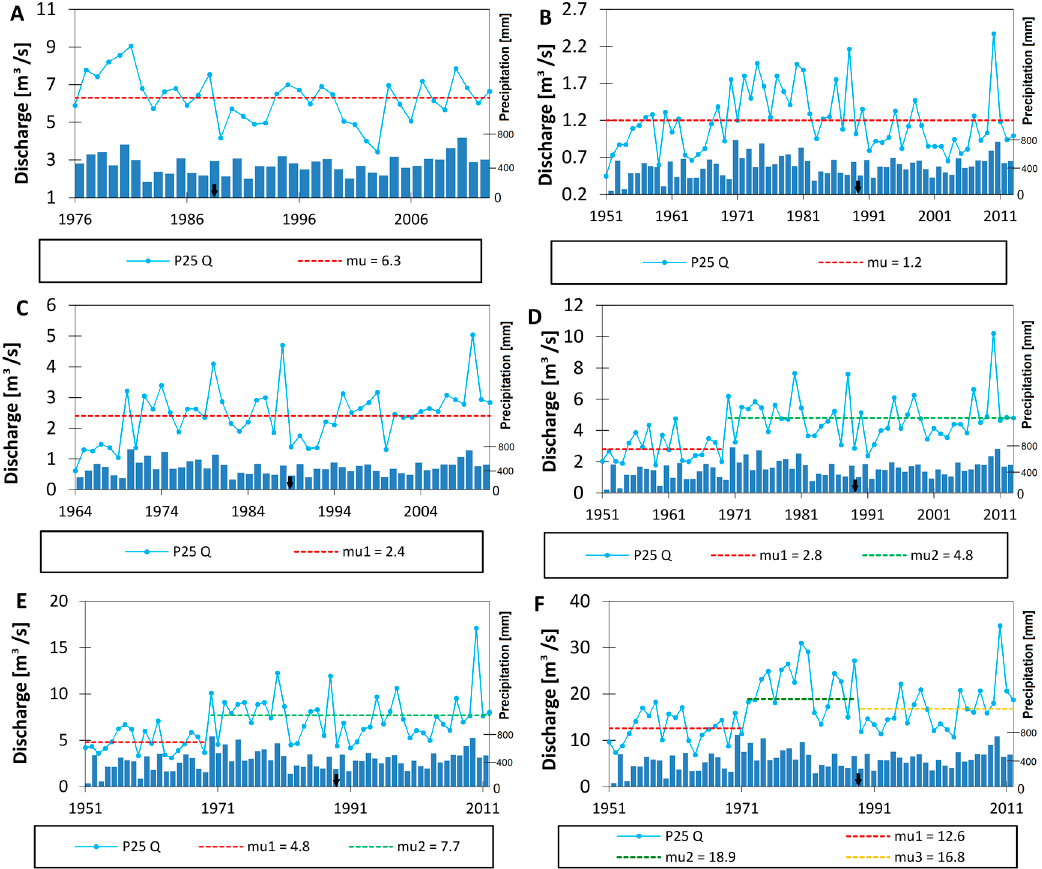
Figure 4. Annual first quartile discharge for selected gauge stations in the Upper Narew Catchment: ( A ) Fasty, ( B ) Narewka, ( C ) Bondary, ( D ) Narew, ( E ) Sura ż , and ( F ) Str ę kowa Góra. “mu” stands for the average value of each time period. The black arrow indicates the year the SR started operation.